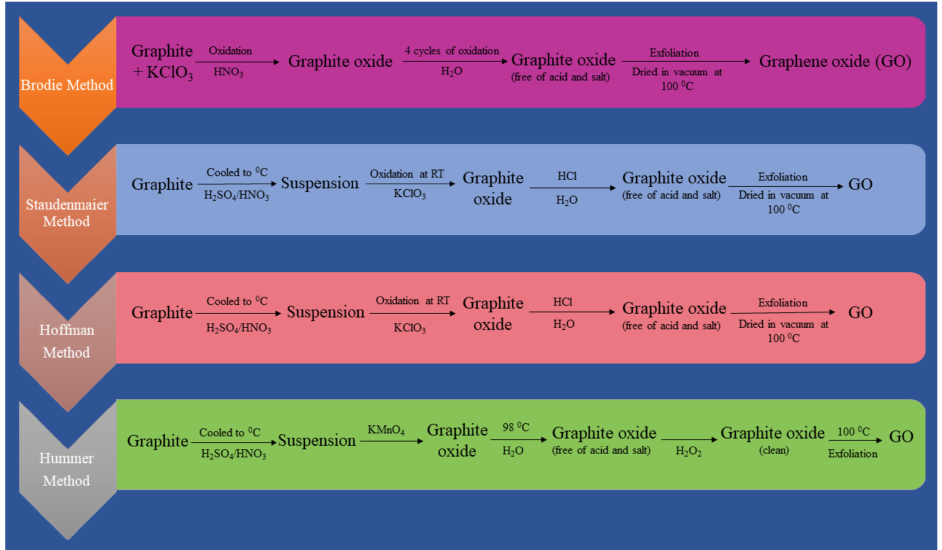
Figure 3. Graphite oxidation route